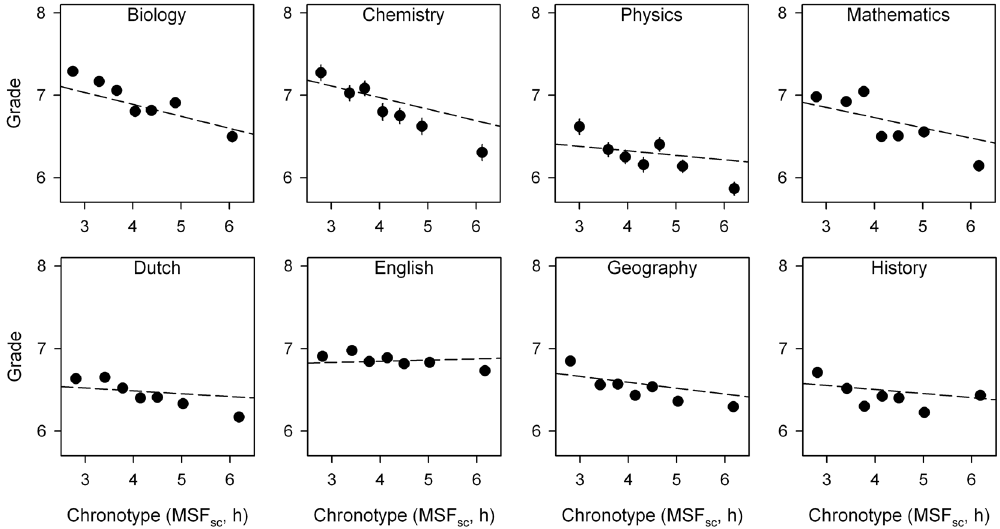
Figure 3. Influence of chronotype (MSF sc ) on grades by subject. Data points represent mean grades with standard error of the mean (SEM). Since the SEM were very small, error bars are not always visible. Mean grades were calculated for 7 equal-sized groups of students based on chronotype (lower numbers correspond to earlier chronotypes and higher numbers to later chronotypes, respectively). Regression lines representing the association between chronotype and grades (raw data) were calculated with multilevel mixed modelling separately per each subject. The raw data are shown in Supplementary Figure S2. The influence of chronotype on grades was significant only for geography, biology, chemistry, and